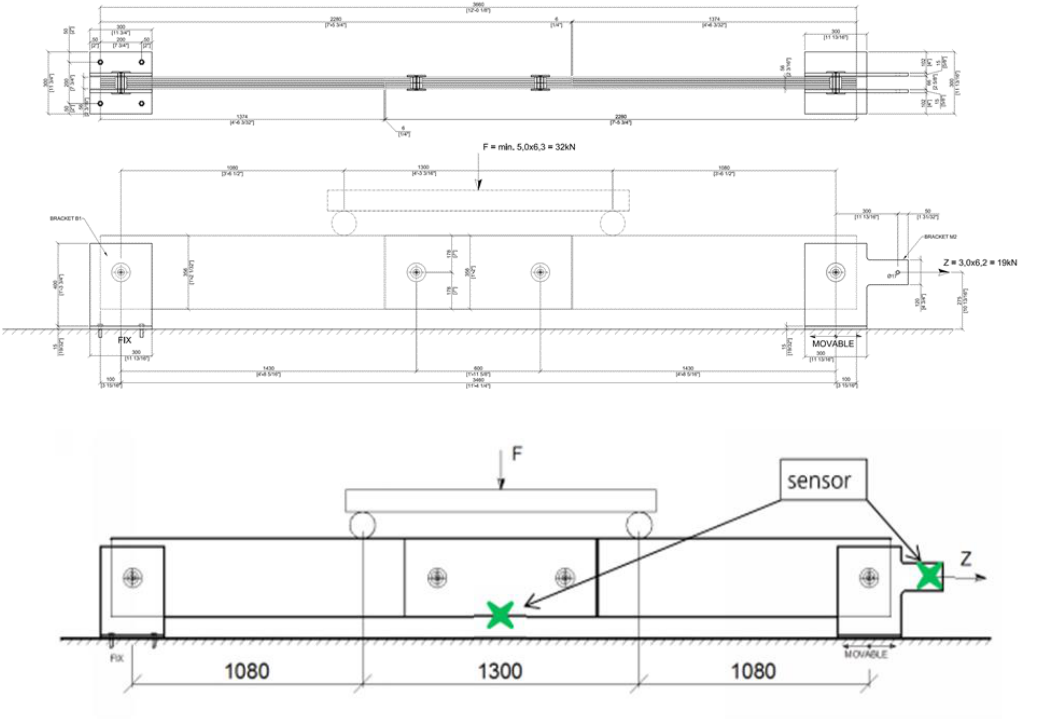
Fig. 7 Glass fin splice